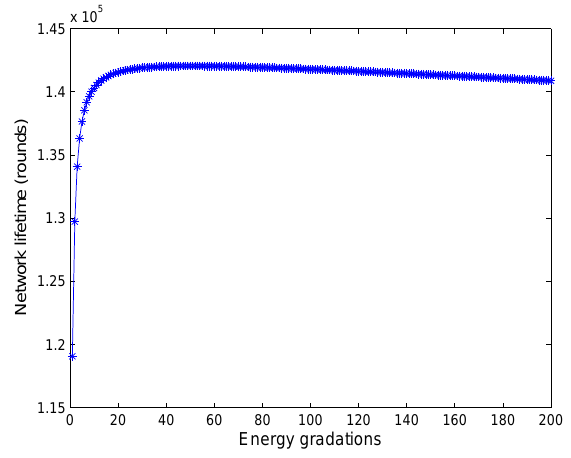
Figure 13. Energy gradations vs network lifetime.